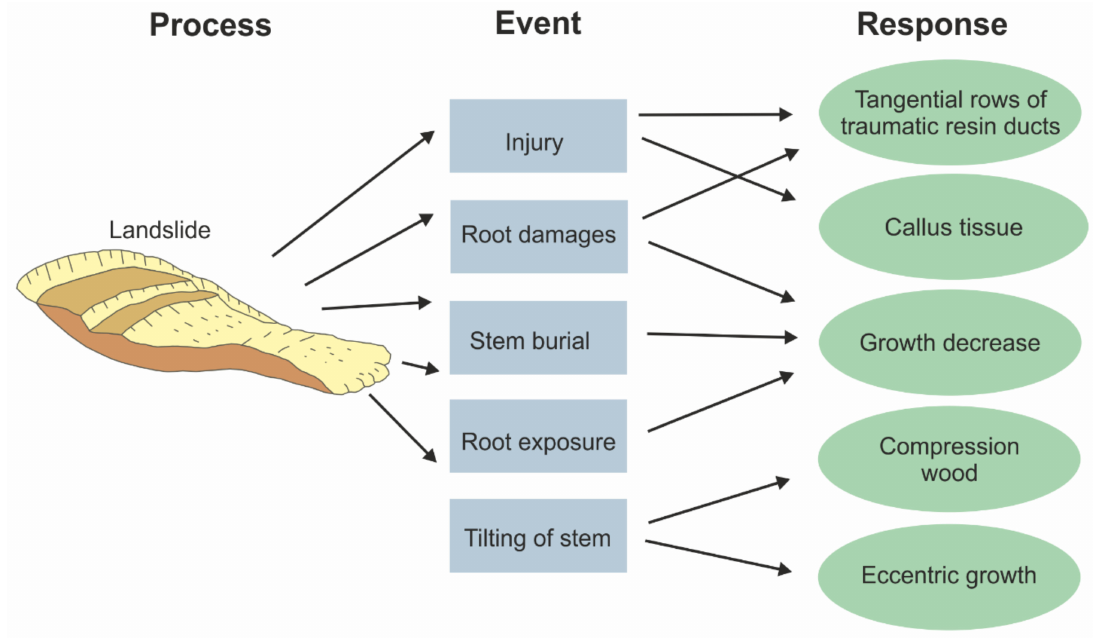
Figure 1. The principle of landslide vs. tree growth interaction (adapted after